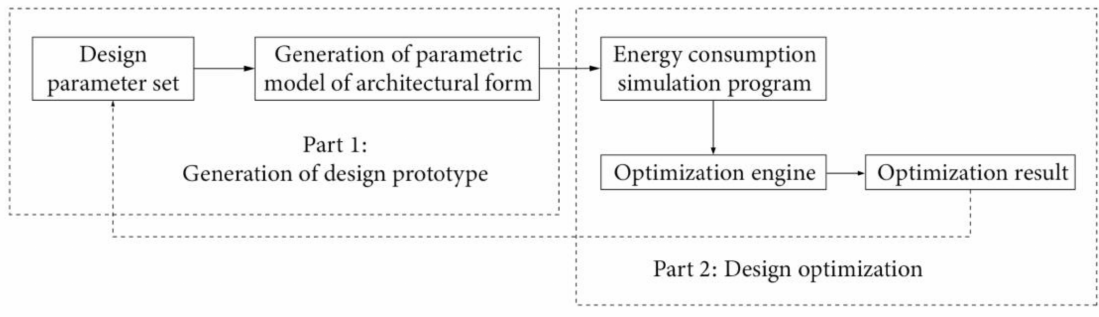
Figure 5. Simulation-based modeling process for building form generation and